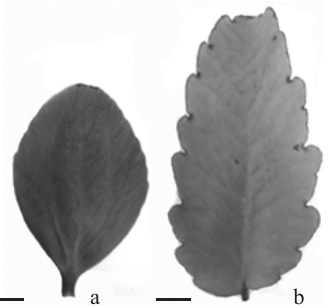
a Fig. 1 - Leaf of Kalanchoe brasiliensis (a) and terminal leaflet of Kalanchoe pinnata (b). Bars = 10mm.